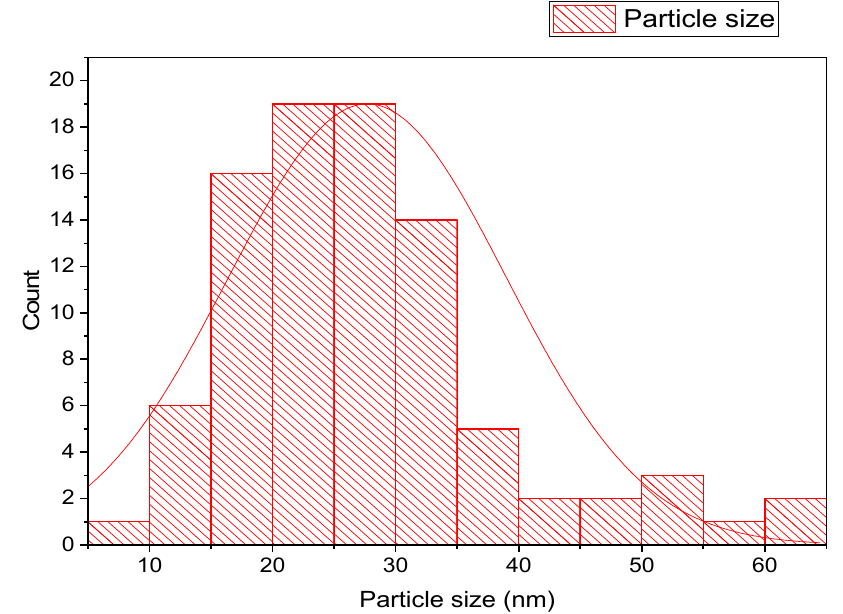
Figure 4. Particle size distribution histogram of AgNPs based on TEM micrographs.